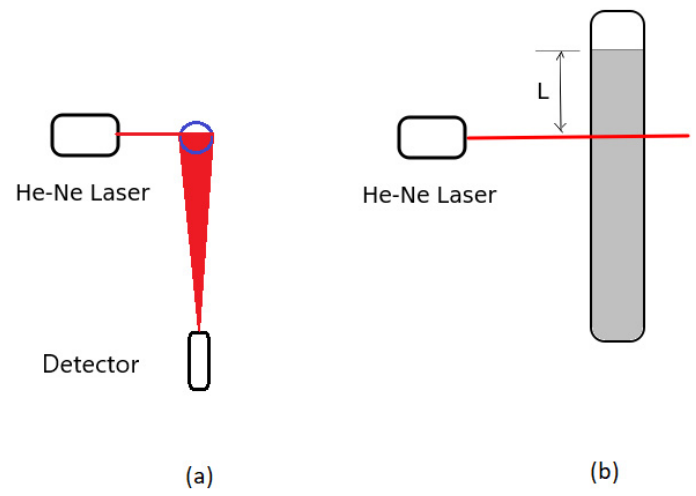
Figure 1. ( a ) The DLS setup, view from above; ( b ) The sedimentation setup. The DAS sampling rate was 16 kHz both for the simulated and for the experimentally recorded TS and the scattering angle to do the recording was chosen to be 90°. Data acqui- sition was carried out using a conventional DAS system [49]. The cuvette—detector distance was 0.1 m and the glass cuvette inner diameter was 0.01 m. The scattering angle θ was 90°,